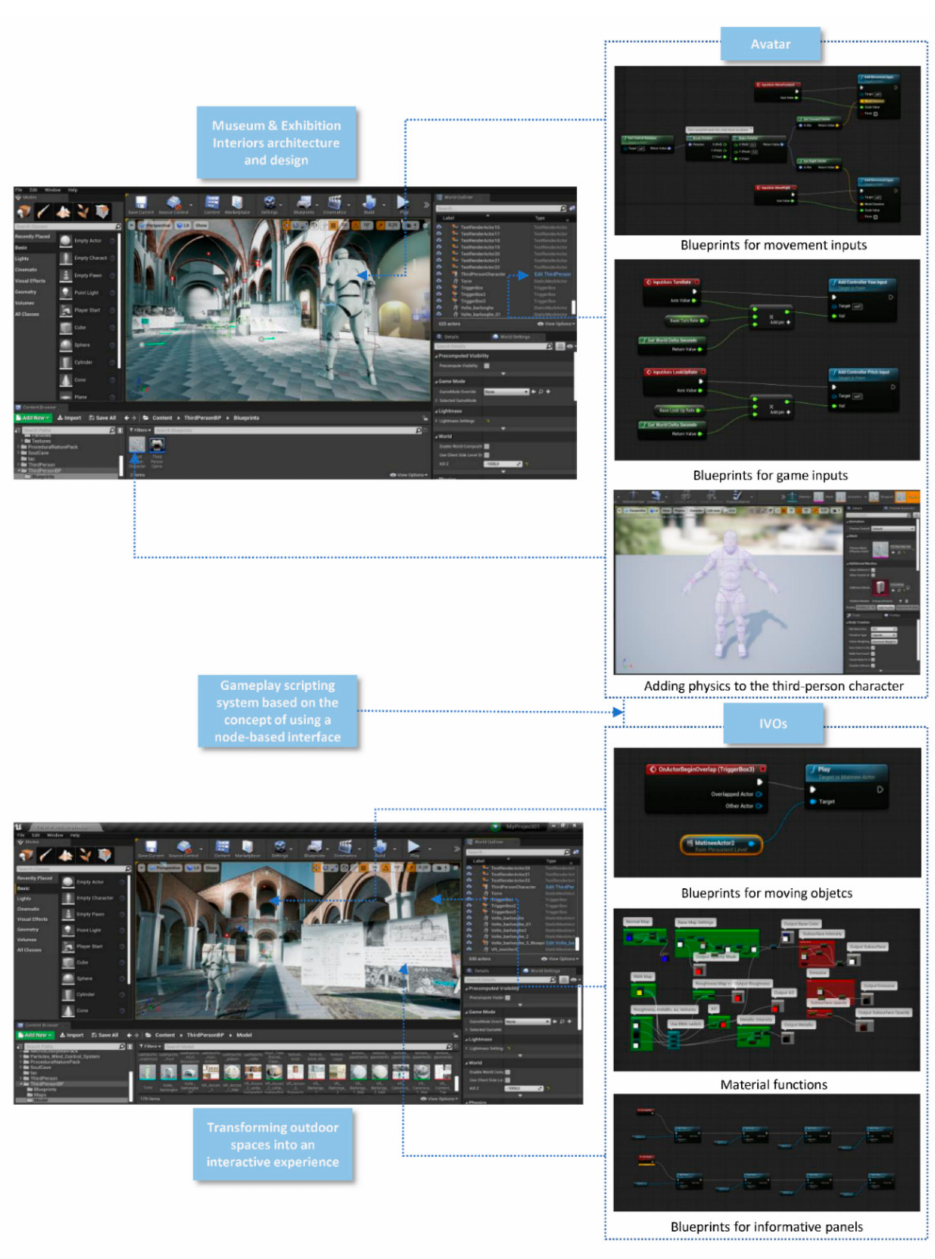
Figure 17. The main blueprints and interactive virtual objects (IVOs) developed for the Basilica of Sant’Ambrogio, Milan (Italy): visual programming language (VPL) lets users create programs by manipulating program elements graphically rather than specifying them